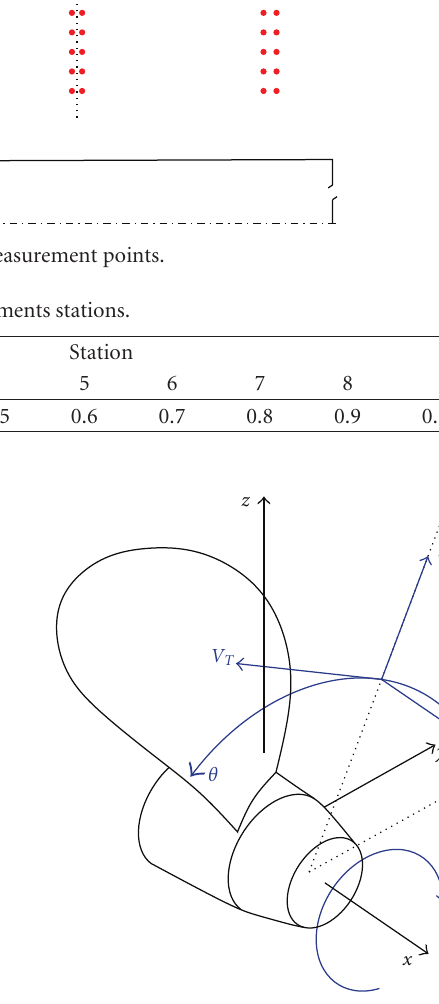
Figure 4: Coordinate reference system and velocity